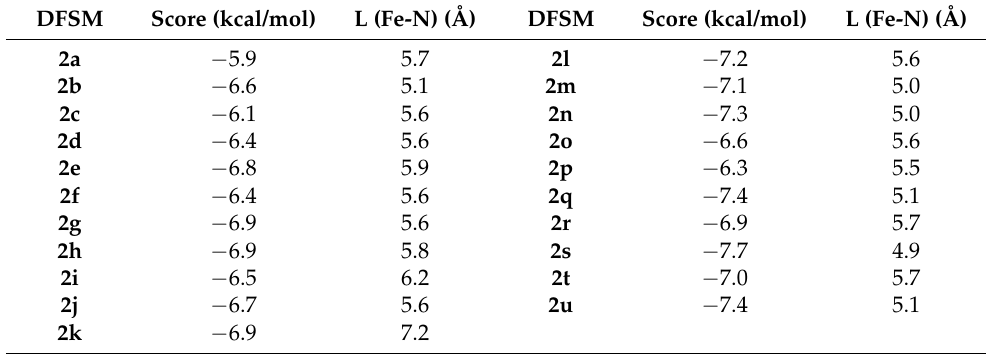
Table 1. Docking simulation of DFSMs.